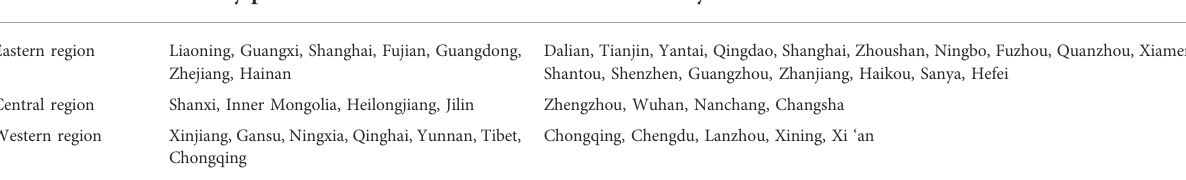
TABLE 1 Key provinces and cities along the